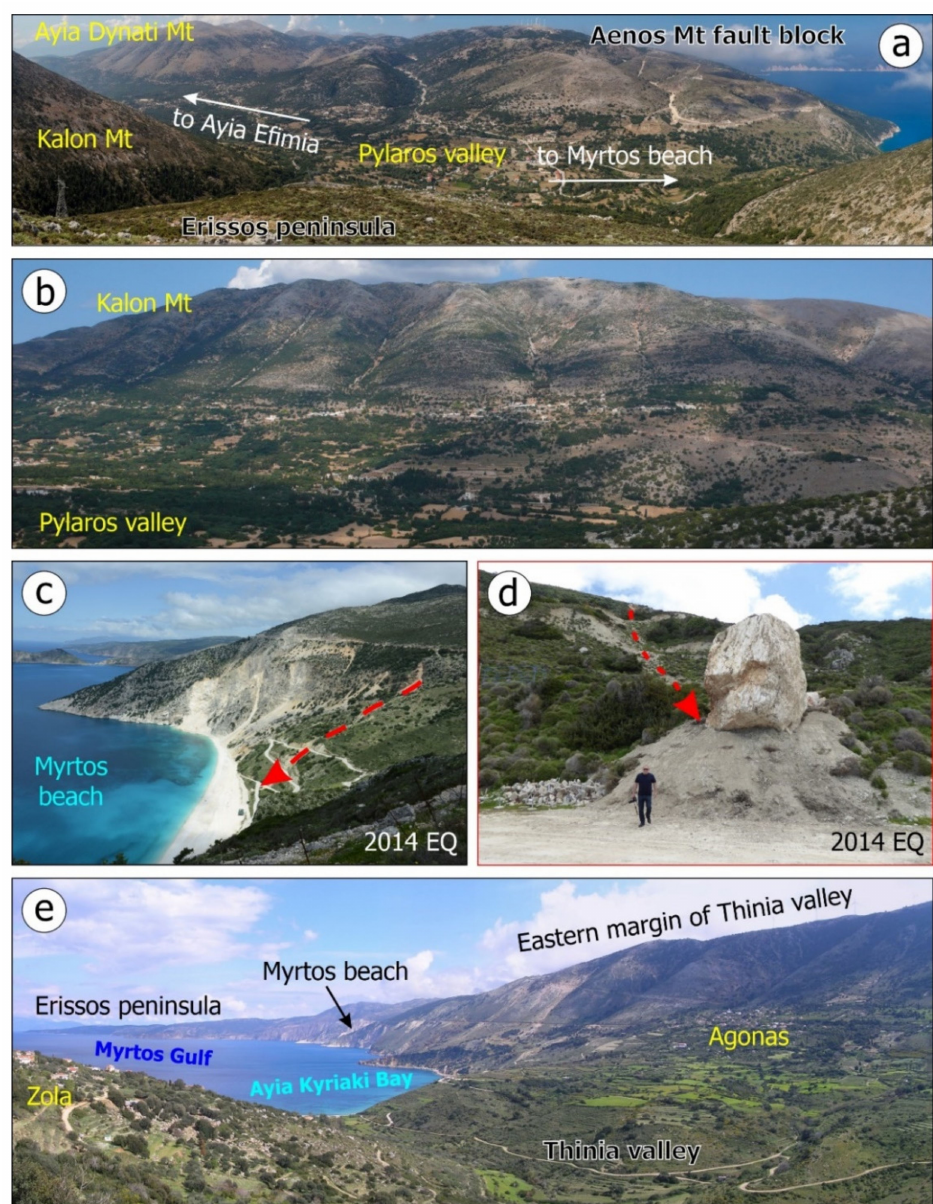
Figure 9. ( a ) View of the Pylaros valley from the north. It is a NW–SE-trending valley formed along the transition zone from Erissos peninsula and located northwards to the Aenos fault block, located southwards. Failures, mainly rockfalls, were triggered by the 12 August 1953 Ionian Sea earthquake along the slopes of Ayia Dynati Mt ( a ) belonging to the fault block of Aenos Mt) and Kalon Mt ( b ) belonging to the fault block of Erissos peninsula). ( c ) The coastal areas of Myrtos occurred at the northwestern part of the transition zone between the fault block of Erissos peninsula located northwards and the Aenos Mt fault block located southwards. It constitutes a zone with very high landslide susceptibility, affected not only by earthquakes, such as the early 2014 earthquakes [11] but also by intense hydrometeorological effects, such as the Ianos medicane in September 2020 [45]. ( d ) In 2014, a limestone boulder detached from the slope, rolled down and reached Myrtos beach. ( e ) The eastern margin of Thinia valley, which was affected by slope failures induced by the 12 August 1953 earthquake. Similar effects in this area were also induced by the early 2014 Cephalonia earthquakes